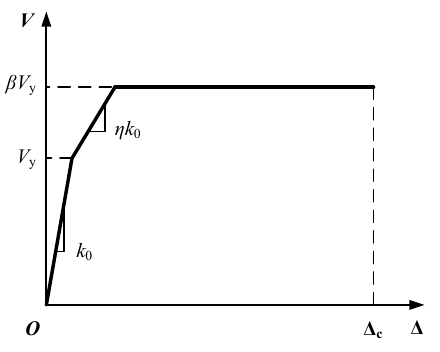
Figure 3. Backbone curve of the MDOF shear model.